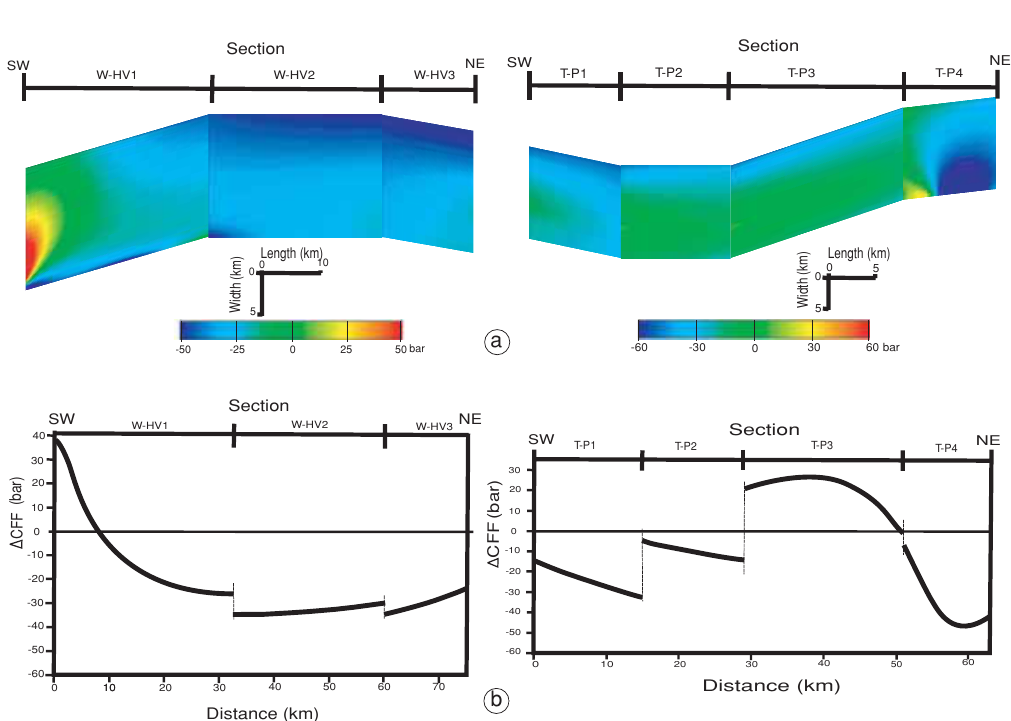
Fig. 6a,b. The distribution of (cid:54) CFSs on the Wellington Fault for the listric Wairarapa Fault Model. a) The cal- culated stress changes were resolved onto the rectangular surfaces, representing the fault planes of the W-HV segment and the T-P segment of our interest. b) The (cid:54) CFSs is resolved to the W-HV segment and T-P segment at the mid-seismogenic depths of 10 km. Since we lack hypocentral depths for the strong earthquakes in the Wellington region, we sample stress in the central part of the seismogenic layer in a way as Harris and Simpson (1992), Simpson and Reasenberg (1994) and Stein et al. (1997) have ever